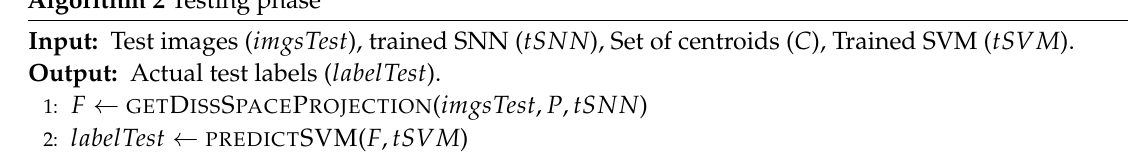
Algorithm 3. Steps 5–8 are repeated for each training iteration. Step 5 extracts randomly batchSize spectrograms pairs from the training set using the function GET S IAMESE B ATCH . Step 6 feeds the